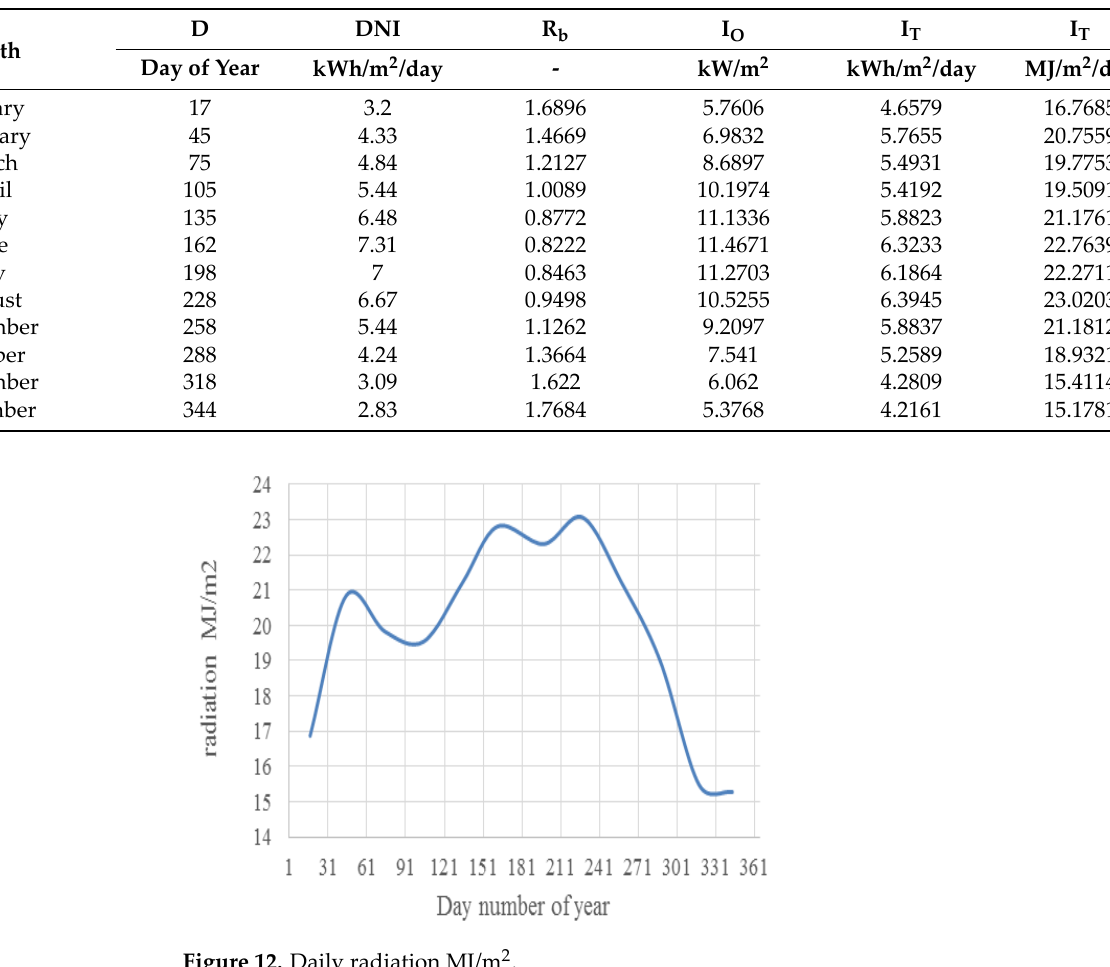
Figure 13. Outlet temperature from the collector in similar research in different lengths of absorber tube. The temperature of the fluid at the inlet point of the CPC collector adsorbent can be continuously measured with a thermometer. The results of the water outlet temperature